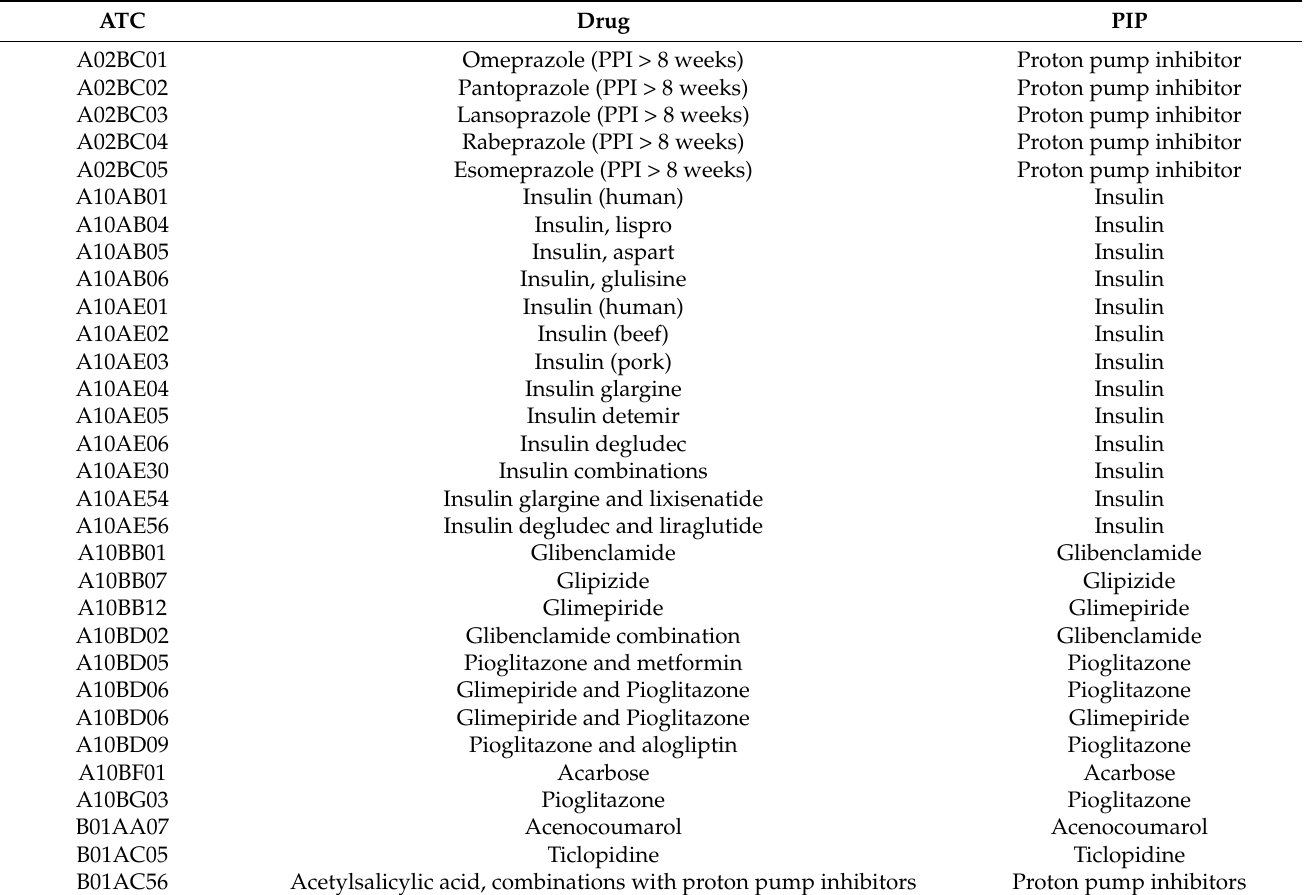
Table A1. Full list of potentially inappropriate prescriptions (PIP) considered in the